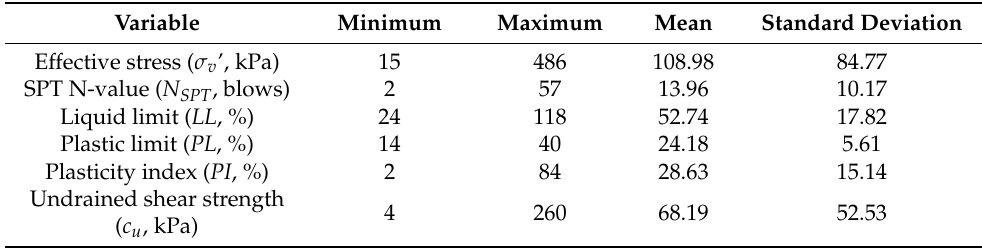
Table 3. Descriptive statistics of